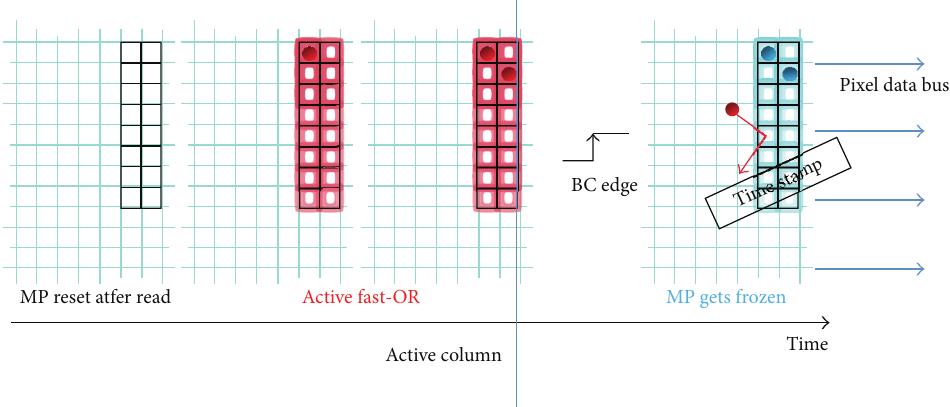
Figure 22: MP working phases.